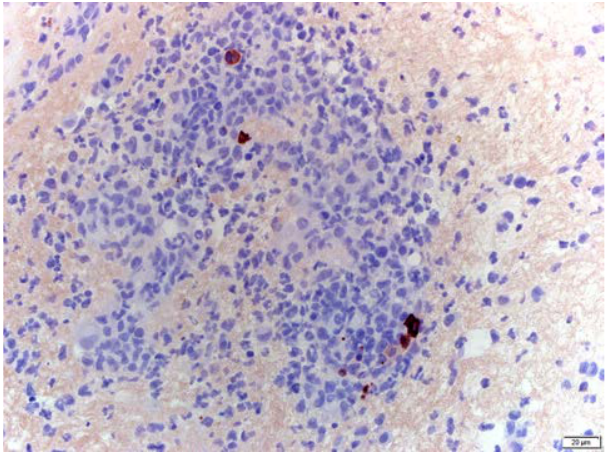
Figure 2B: Immunohistochemistry on a similar section at 40x magnification. The red-brown material indicates coronavirus in the cytoplasm of infected macrophages. It is quite typical for positively staining macrophages to be as infrequent as in this case. The pale brown background material reflects non-specific labelling (Dr Clift, personal communication)